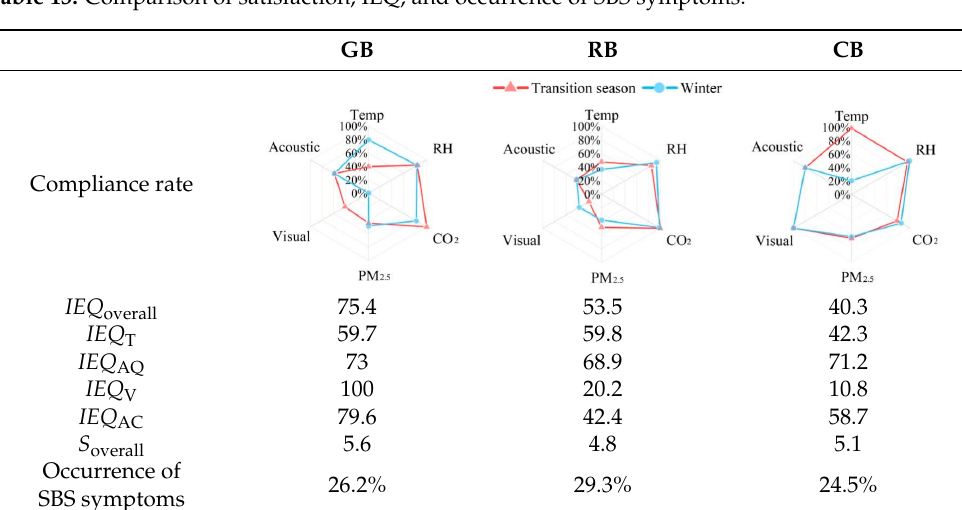
Table 12. Weightings of different indoor environment parameters.